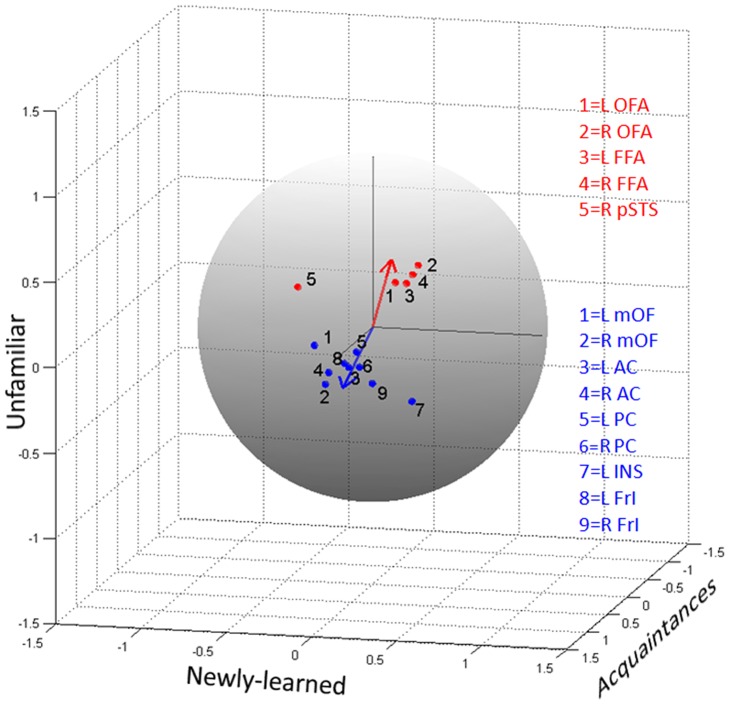
Activation profile in the tuning space.Each ROI is represented in the unitary sphere as a normalized three dimensional vector composed by the response to each face condition. The areas of the estimated HRF were used to describe the intensity of the response to each face condition. The core system ROIs are shown in red, while the extended system ROIs are in blue. The red vector is the mean profile of four ROIs of the core system (bilateral OFA and FFA). The blue vector is the mean profile of the extended system ROIs.